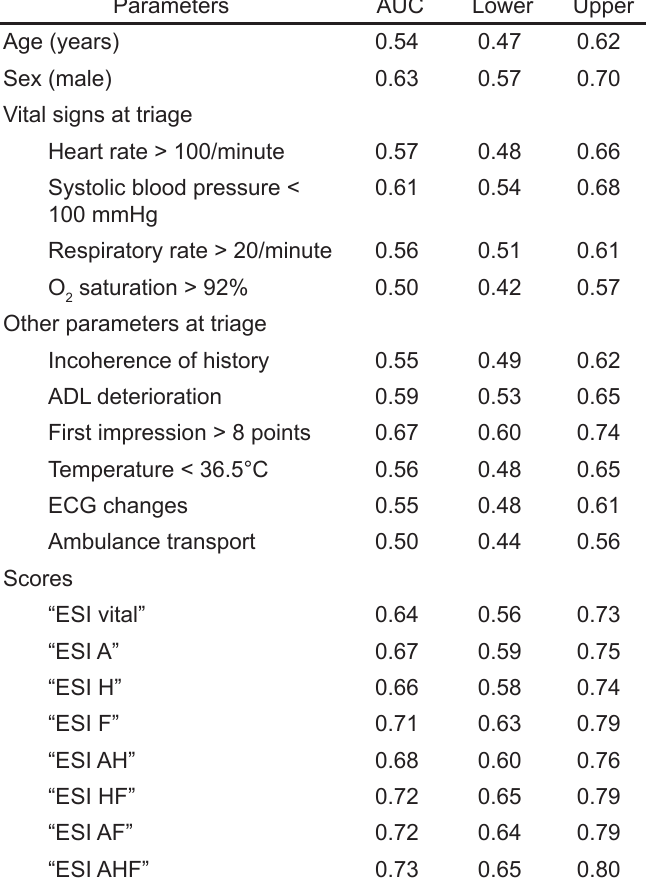
Table 3. Odds ratios (OR) for all parameters tested for an association with 30-day